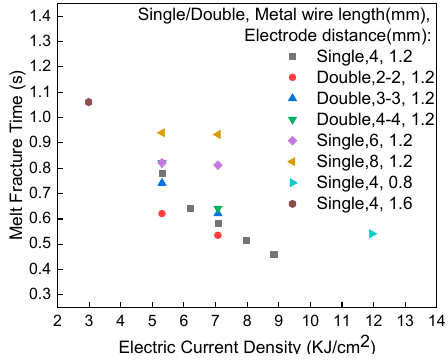
Figure 13. Dependence of the time-to-fusing on electric current density.